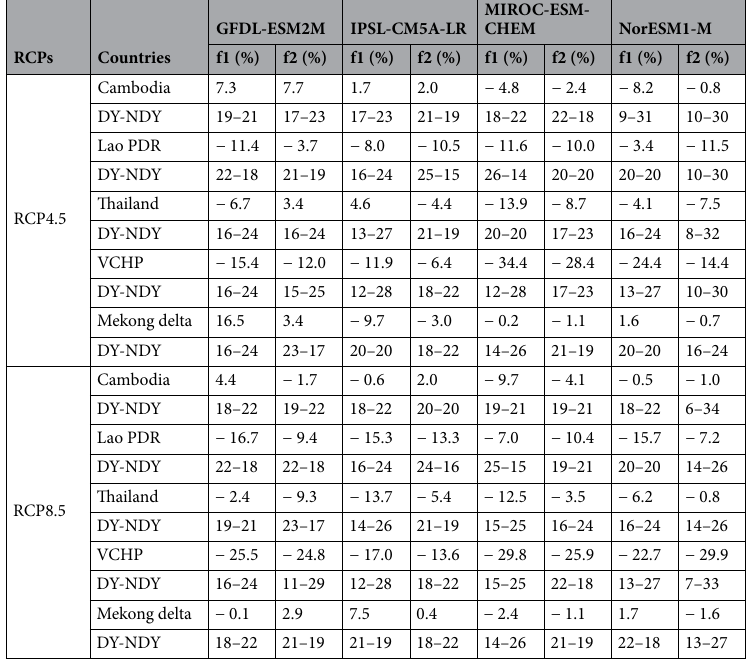
Table 2. Precipitation differences during crop growing season between drought and non-drought year for each climate model and future period (Unit: %). The numbers of drought and non-drought year were stated below the differences. Negative values indicate the decreases in precipitation during drought years. DY Drought year, NDY Non-drought year, VCHP Vietnam Central High